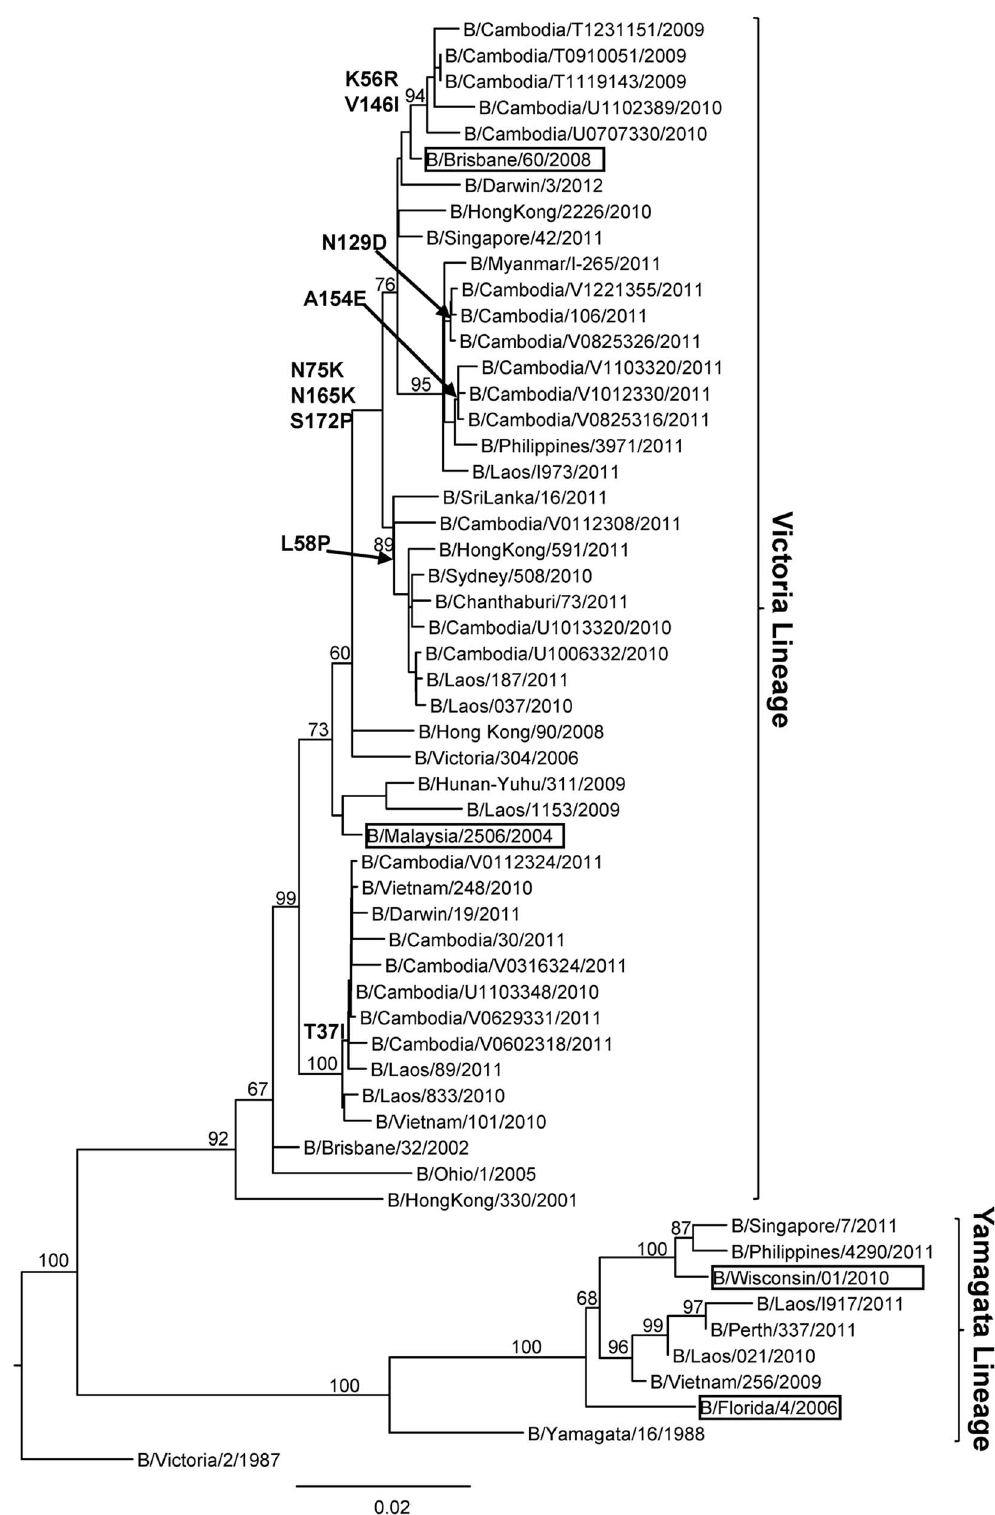
Figure 5. Phylogenetic analysis of the HA1 domains of the HA genes (sequences of 1041 nucleotides (nt 46–1086)) of influenza B virus isolates collected in Cambodia from 2009 to 2011. The phylogenetic analysis was conducted as a distance-based neighbour-joining phylogenetic tree of influenza using the HKY model and generated using PAUP software with 1,000 bootstrap replicates (values $ 60 shown on branch) and rooted to B/Victoria/2/1987. Major amino acid changes are shown in block letters at the appropriate nodes. The vaccine reference strains are boxed. Scale bar indicates number of nucleotide substitution per site.